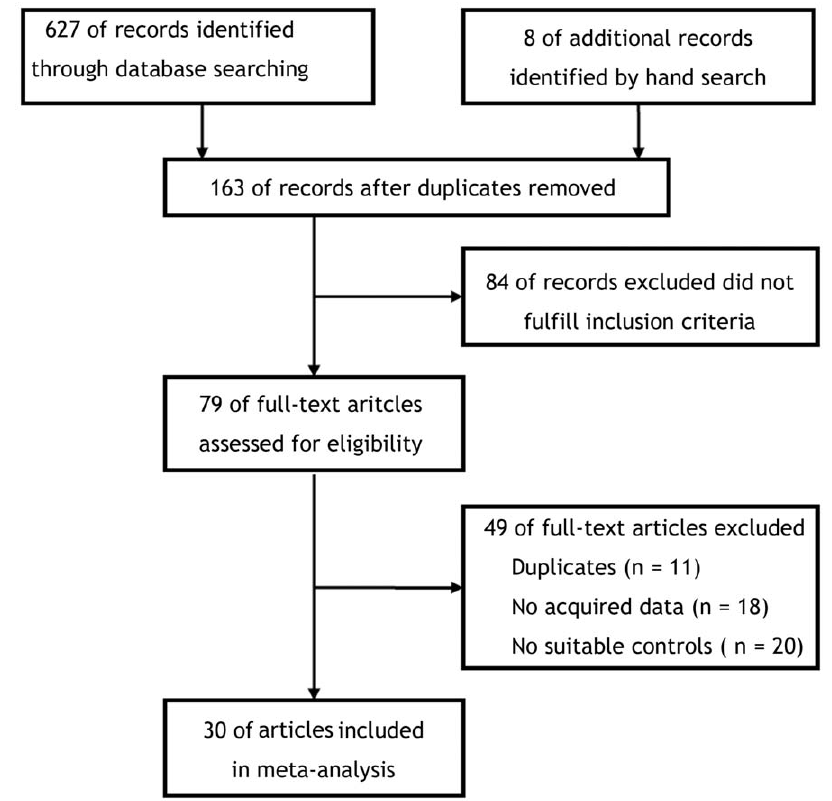
Figure 1. A flow chart showing the progress of trials through the review.